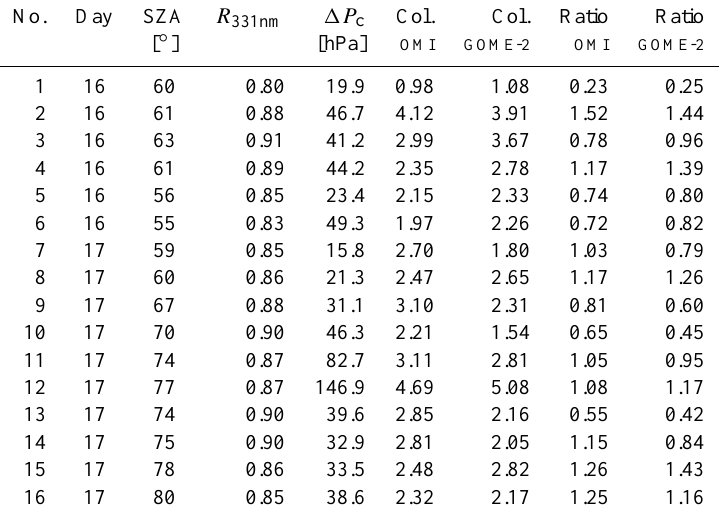
Table 3. Satellite-derived information corresponding to DC-8 BrO profile locations shown in Fig. 1. Units and abbreviations are as used in Tables 1, 2a and b. “Ratio OMI ” means ratio of the OMI-derived tropospheric column to the in-situ column. “Ratio GOME − 2 ” is the same but for